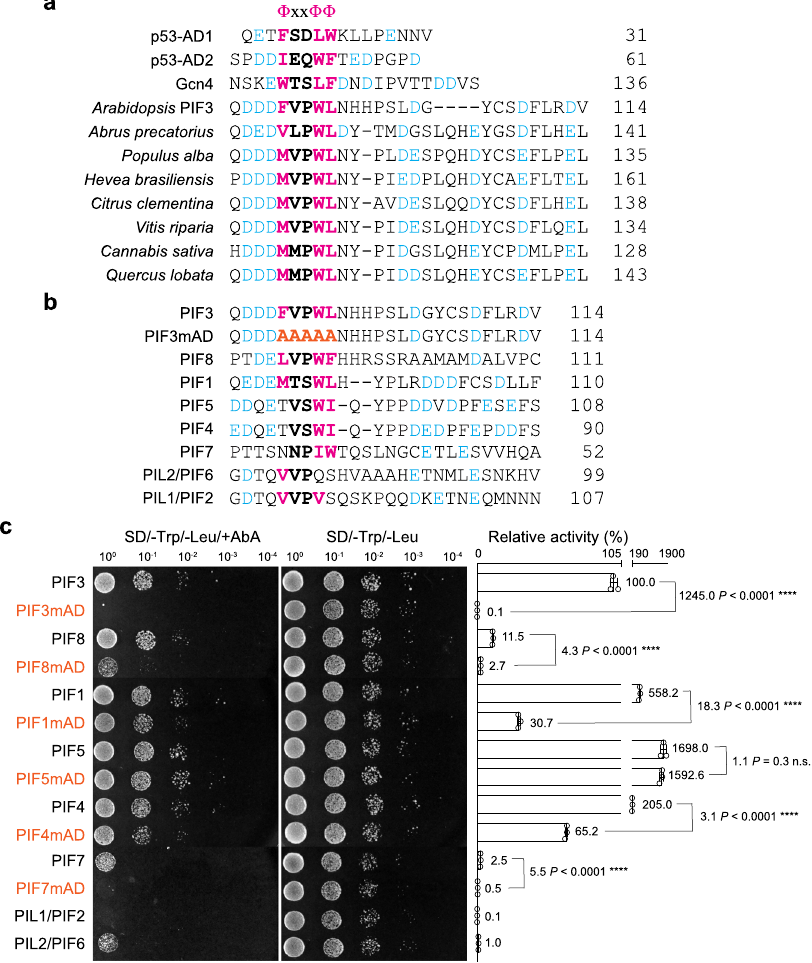
Fig. 2 PIF3 possesses a p53-like AD. a Amino acid sequence alignment of the ADs of Homo sapiens p53 (BAC16799.1), Saccharomyces cerevisiae Gcn4 (QHB08060.1), and select PIF3 orthologs from eudicots, including Arabidopsis thaliana (NP_001318964.1), Abrus precatorius (XP_027363600.1), Populus alba (XP_034896271.1), Hevea brasiliensis (XP_021639209.1), Citrus clementina (XP_006423962.1), Vitis riparia (XP_034707239.1), Cannabis sativa (XP_030504594.1), and Quercus lobata (XP_030957900.1). b Amino acid sequence alignment of the AD regions of PIF3, PIF3mAD, and the other PIF paralogs in Arabidopsis . The substituted alanines in PIF3mAD are labeled in orange. a , b The conserved activator Φ xx ΦΦ motifs are highlighted in bold; the critical hydrophobic residues in the Φ xx ΦΦ motif and the fl anking acidic residues are labeled in magenta and blue, respectively. c Yeast transactivation assays showing the transactivation activities of the full-length PIF3 and PIF3 paralogs in Arabidopsis and the respective mAD mutants of PIF3, PIF8, PIF1, PIF5, PIF4, and PIF7. All mAD mutants contain fi ve alanine substitutions in the predicted Φ xx ΦΦ motif regions shown in ( b ). The left panel shows serial dilutions of the yeast strains containing the respective constructs grown on either SD/-Trp/-Leu/ + AbA or SD/-Trp/-Leu (control) media. The right panel shows the relative transactivation activities quanti fi ed using the yeast liquid β -galactosidase assay. The transactivation activities were calculated relative to that of PIF3. Error bars represent the s.d. of three biological replicates; the centers of the error bars represent the mean values; the numbers represent the mean value of the relative activity. Fold changes in the activity of mAD mutants relative to their respective wild-type proteins are denoted. The statistical signi fi cance of the changes between the mAD mutants and their respective wild-type proteins was analyzed by two-tailed Student ’ s t -test (**** P ≤ 0.0001, n.s. indicates no signi fi cant difference). The source data underlying the yeast liquid β -galactosidase assays in ( c ) are provided in the Source data fi